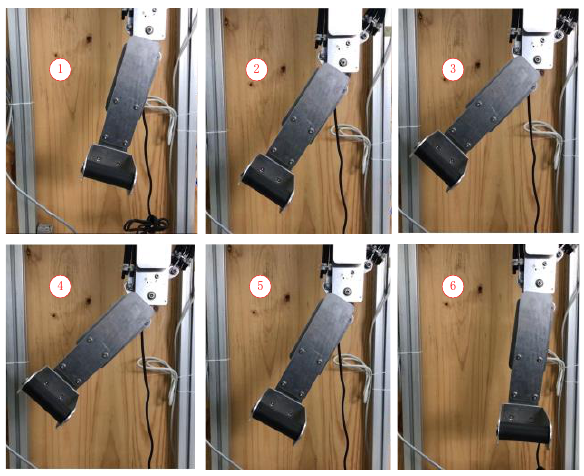
Figure 9. Passive training process under no load.